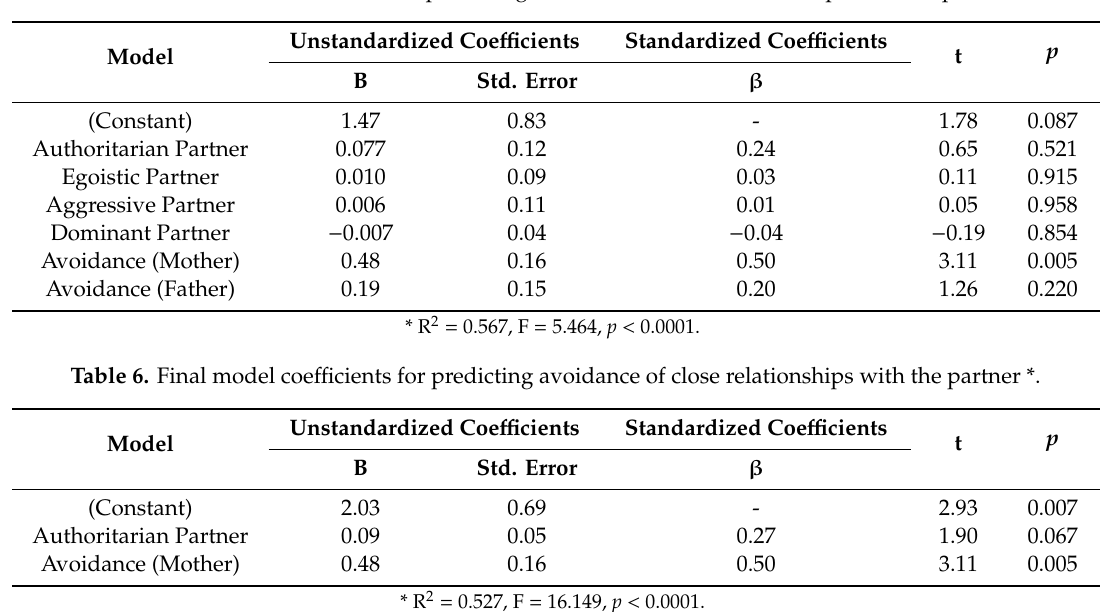
Table 5. Full model coe ffi cients for predicting avoidance of close relationships with the partner *.